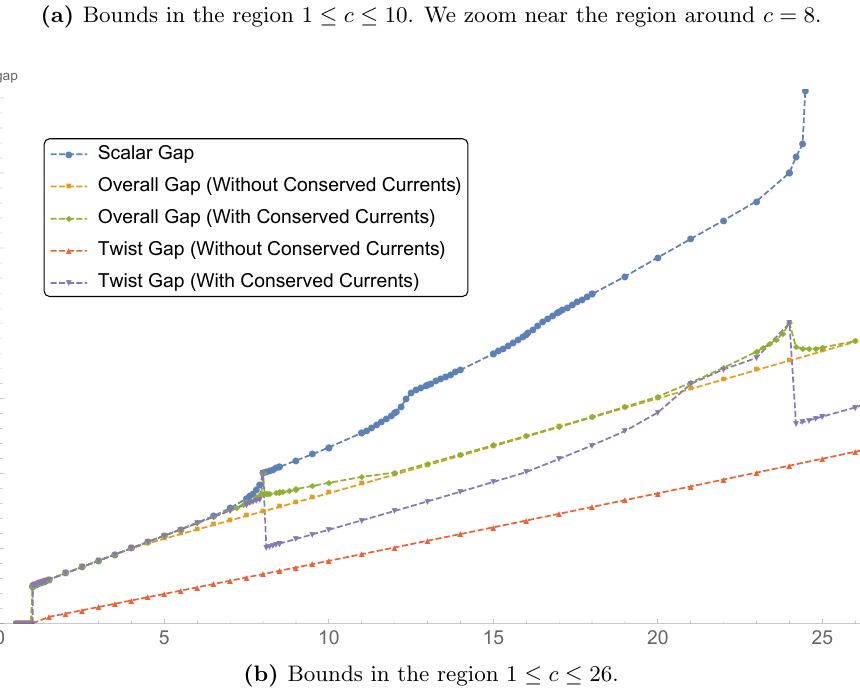
integer degeneracies is realized at the bound for c = 38 charge is identical to the Sugawara central charge for b E point in more detail in section